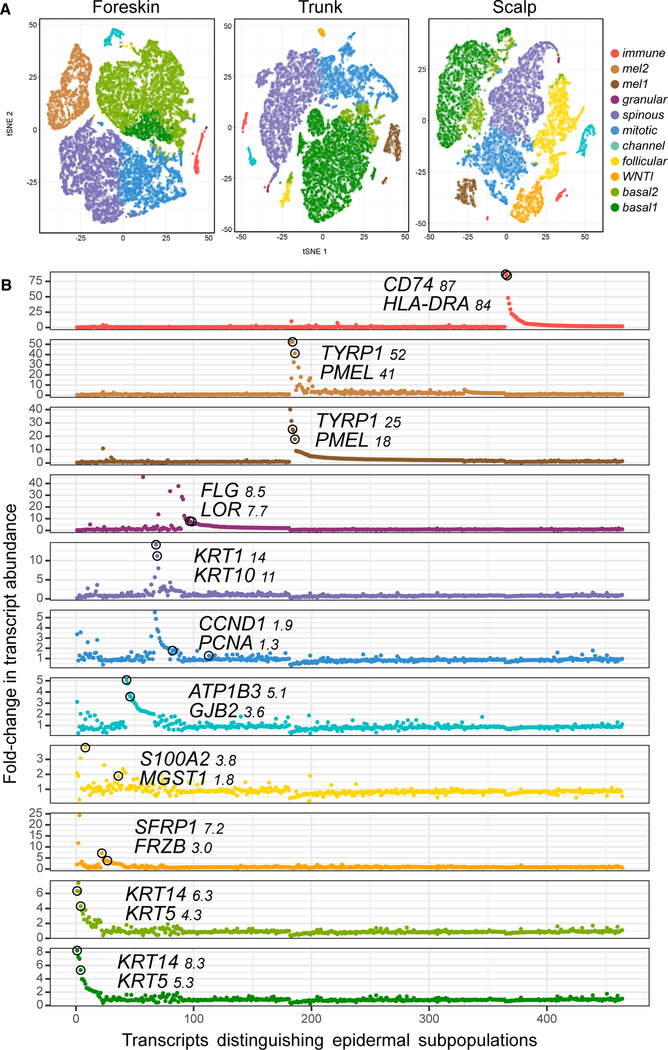
Unbiased Classification of Epidermal Cell Subpopulations in Human Skin(A) t-SNE maps show the relatedness of epidermal cell groups distinguished by spectral clustering from three aggregated samples each from foreskin (26,174 cells), trunk (25,129 cells), and scalp (20,561 cells) (see also Figures S1, S4, and S5 and Data S1). Cells in eight of the 11 clusters express high levels of keratins, identifying them as keratinocytes. Two groups representing melanocytes are coded in brown, and the initial immune cell cluster is depicted in red. (B) Genes with log fold change > 1 in at least 1 cluster ordered by cluster (x axis) and fold change (y axis) (Tables S1, S2, S3, and S6). Genes only appear once, in the first cluster (from bottom to top), where their log fold change passes the threshold. Two genes with specificity for each cluster are named, and their respective coordinates are highlighted with black circles.